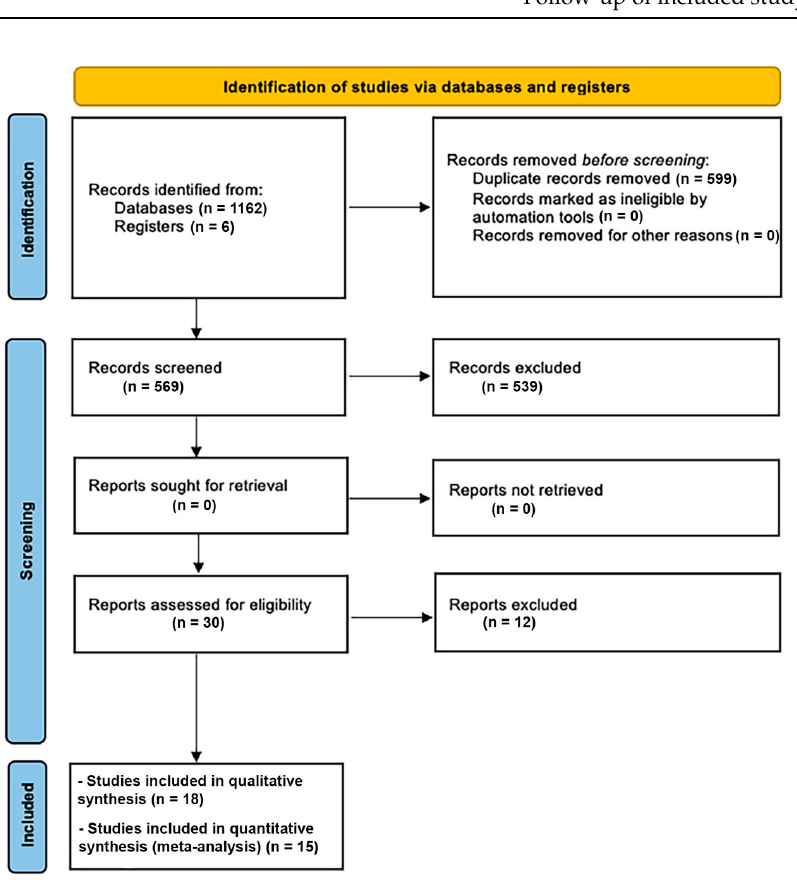
Figure 1. PRISMA flow diagram for the studies inclusion process.